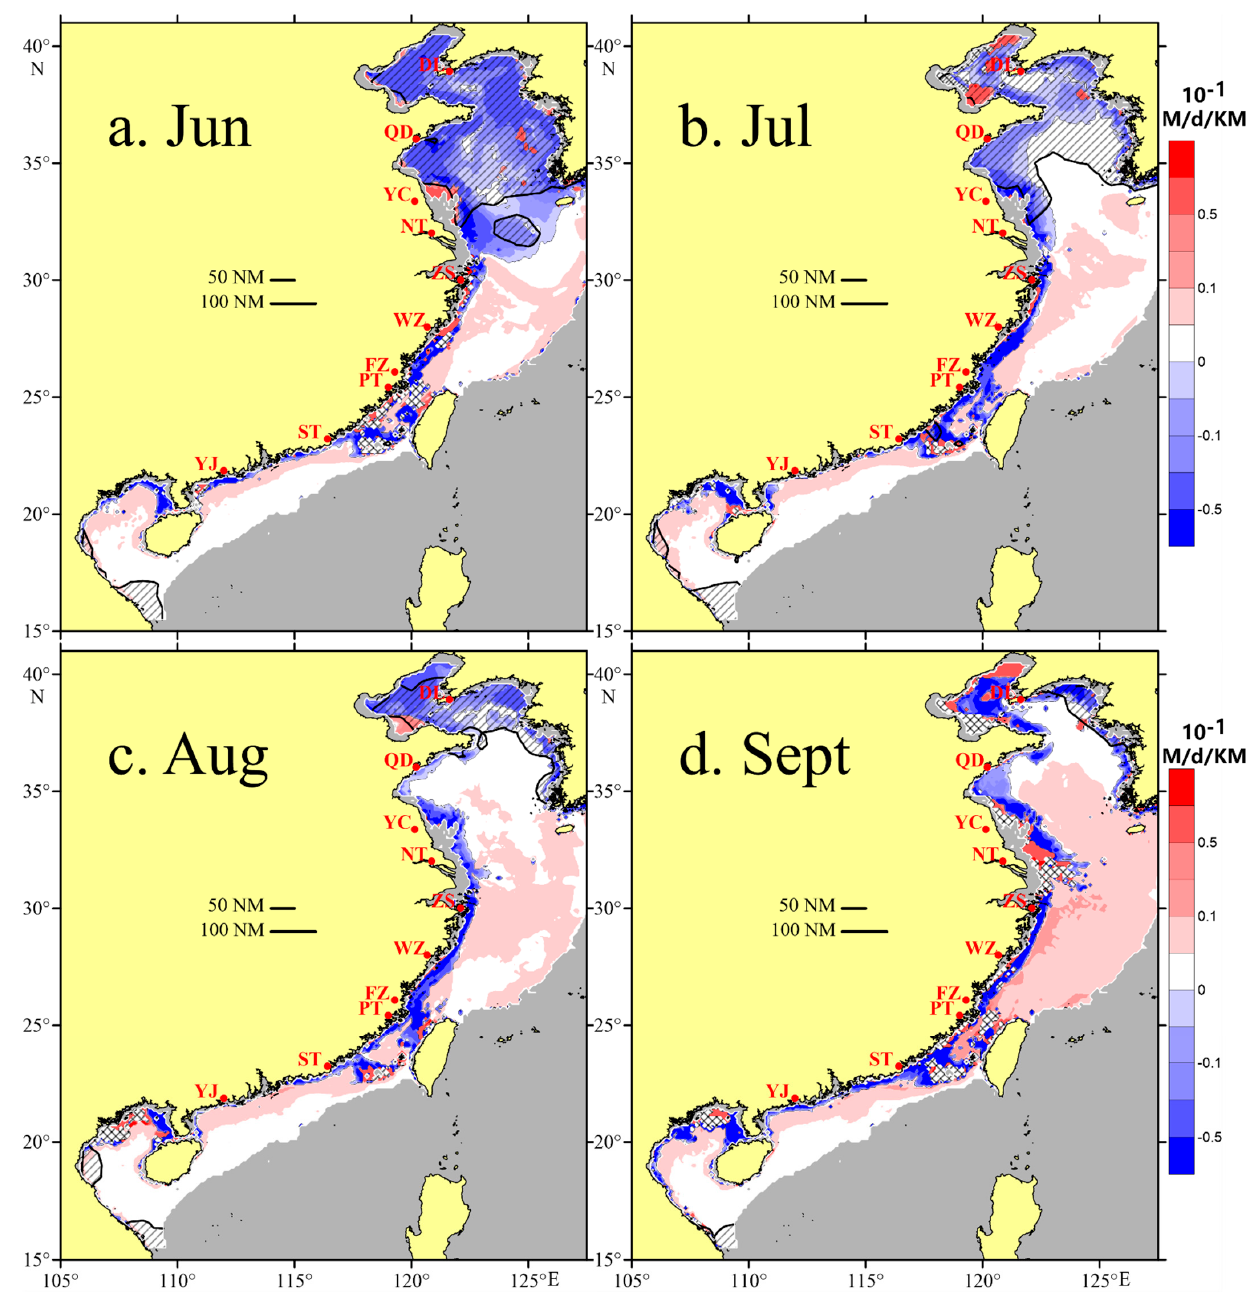
Figure 10. Distribution of the rate of 𝑊 changing (10 − 1 M/d/KM) due to an increase in 𝐿 in the wa ‐ ters adjacent to China. The two horizontal black bars indicate reference lengths of 50 NM and 100 NM, respectively. The regions covered by slashes are of wind speed of less than 5 m/s. The cross ‐ hatching indicates the regions without stratification.